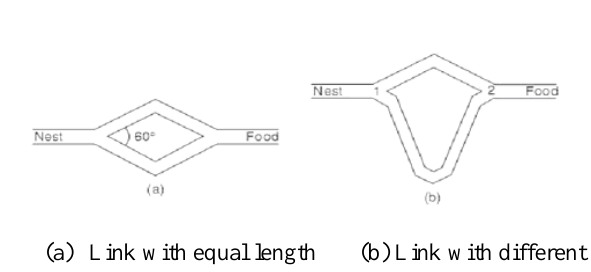
Fig 1: Experimental setup for the double bridge